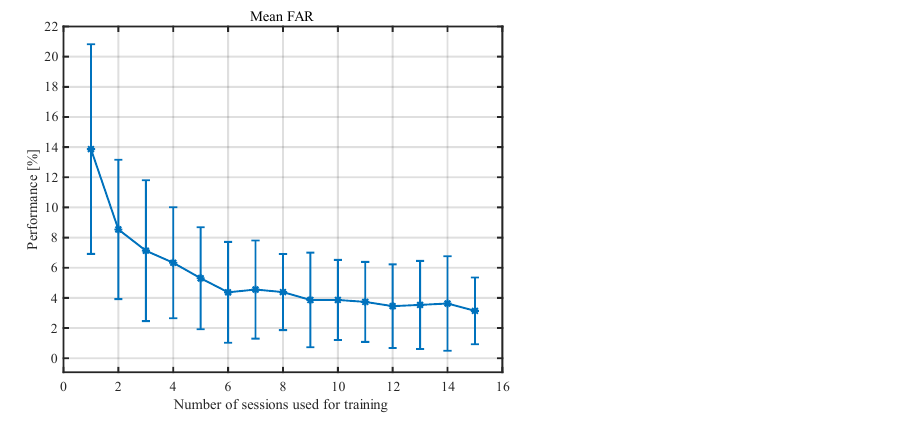
Figure 7. The percentage of successful impostor attacks for different numbers of training recordings.